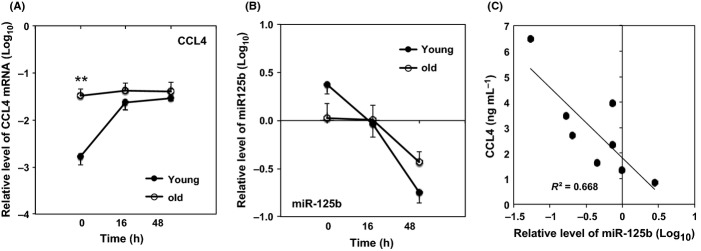
Activation-induced change of CCL4 and miR-125b in naïve CD8 T cells before and after stimulation from young and old adults. (A) Relative CCL4 mRNA and (B) Relative miR-125b levels in naïve CD8 T cells. (C) Correlation of CCL4 protein and miR-125b (N = 8). R2 = 0.7 (linear regression analysis); P = 0.01. Freshly isolated naïve CD8 T cells from young (N = 13–16) and Old (N = 14–16) were stimulated in vitro by antibodies against CD3 and CD28. Cells were harvested at the indicated time for analyses of CCL4 mRNA and miR-125b, and culture supernatant was collected for measurement of CCL4 protein. The levels of CCL4 mRNA and miR-125b were measured by quantitative RT-PCR and normalized to ACOX1 and RNU6B first and then normalized to a standard generated from PBMCs of five normal subjects in Log10 scale, respectively. Both CCL4 and miR-125b were significantly different between 0 and 16 h, and between 0 and 48 h (P < 0.05). CCL4 protein in culture supernatant was determined by ELISA.